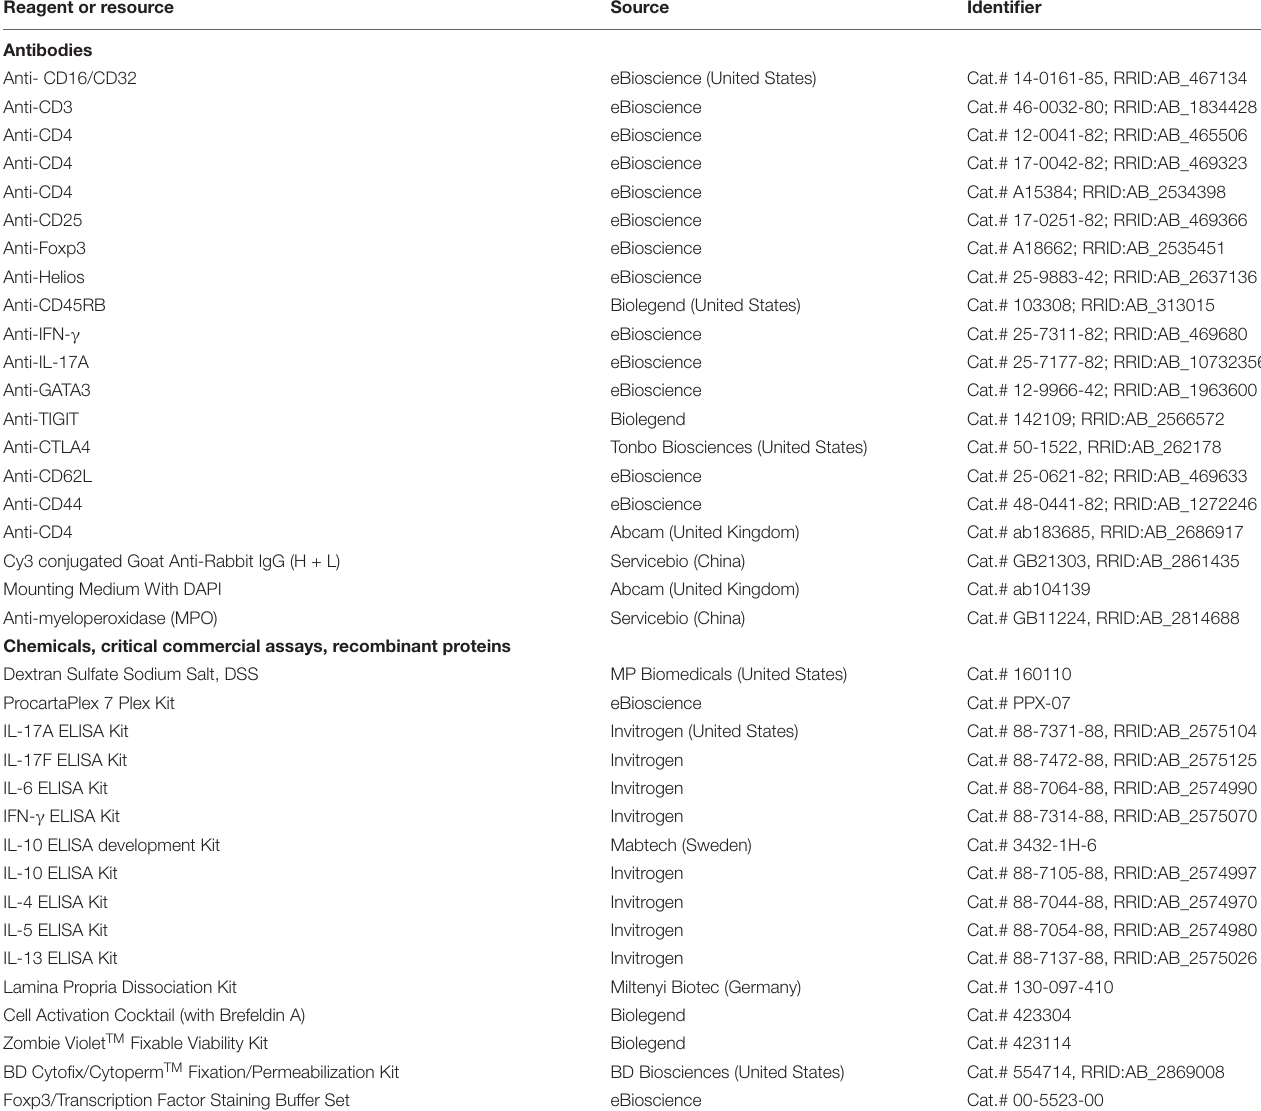
TABLE 2 | The key resources in this study. Reagent or